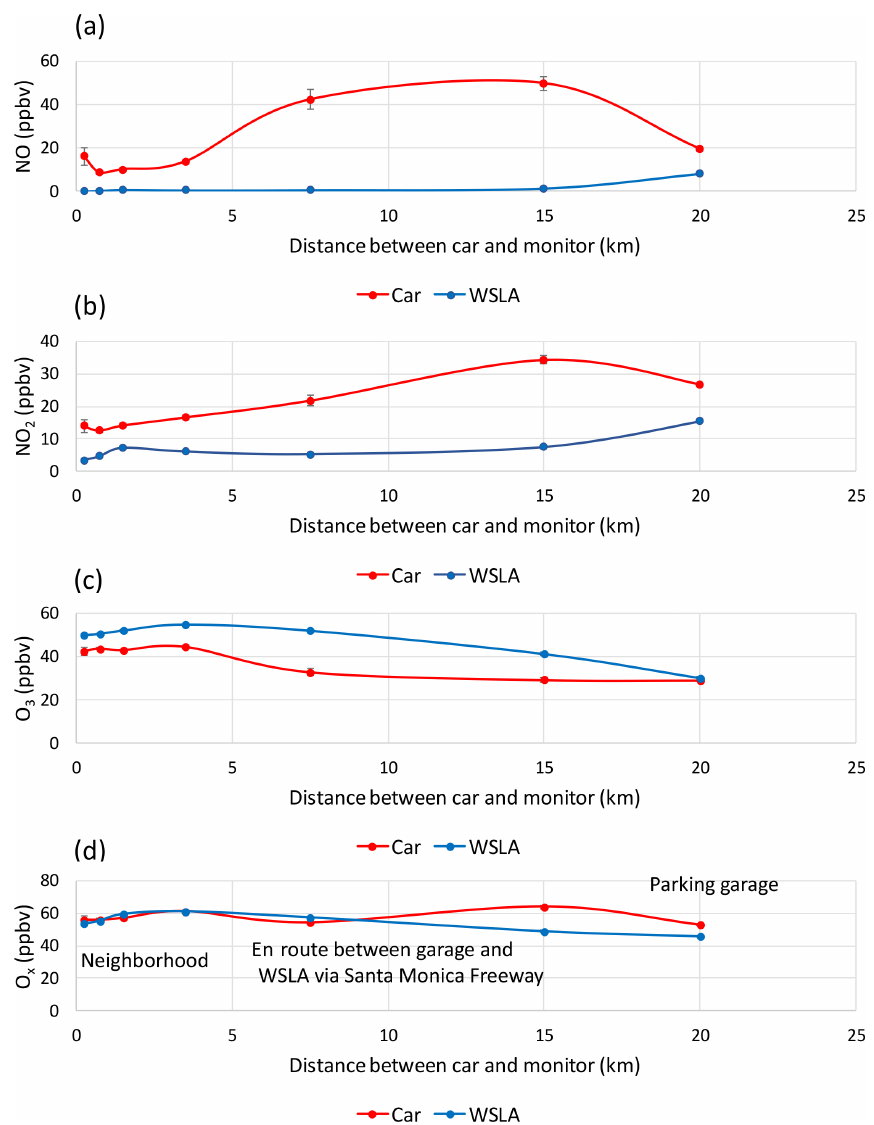
Figure 5. Mobile-platform monitoring and WSLA measurements versus distance between cars and WSLA on 4d (13, 19, 26, and 29 Septem- ber 2016) when the cars drove near WSLA. The first bin includes all distances less than 0.5km; the minimum distance between cars and monitor was 158m. Locations are indicated. Standard errors of the means are shown, but most are smaller than the